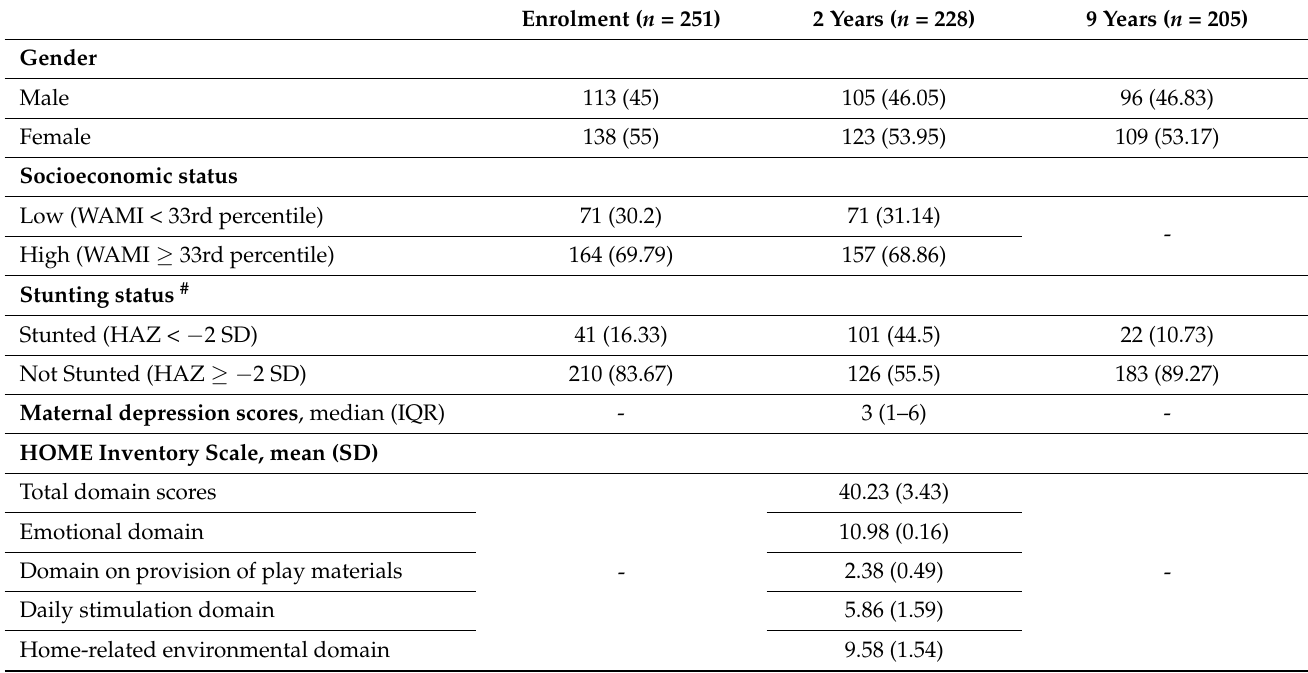
Table 1. Sociodemographic characteristics and HOME inventory scores of MAL-ED cohort at enrol- ment, 2 and 9 years of follow-up.